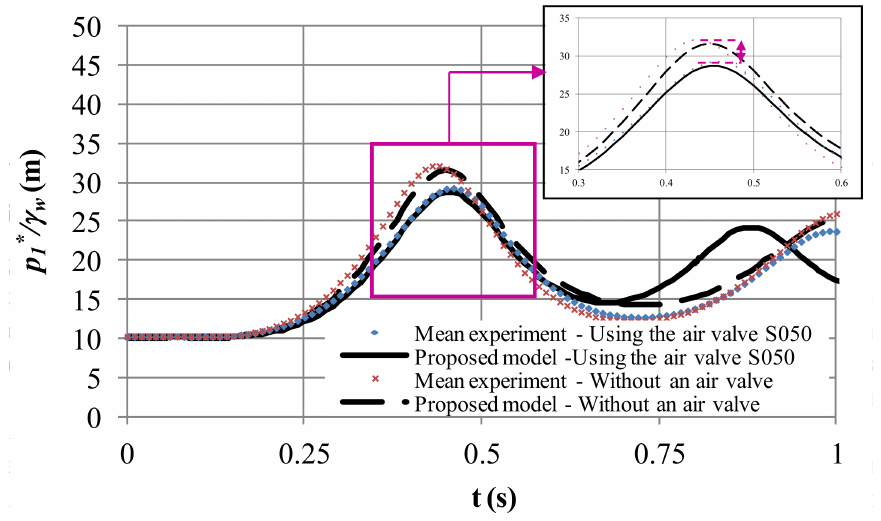
Figure 6. E ff ect of air pocket pressure pattern considering and neglecting the air valve S050 for Test No.